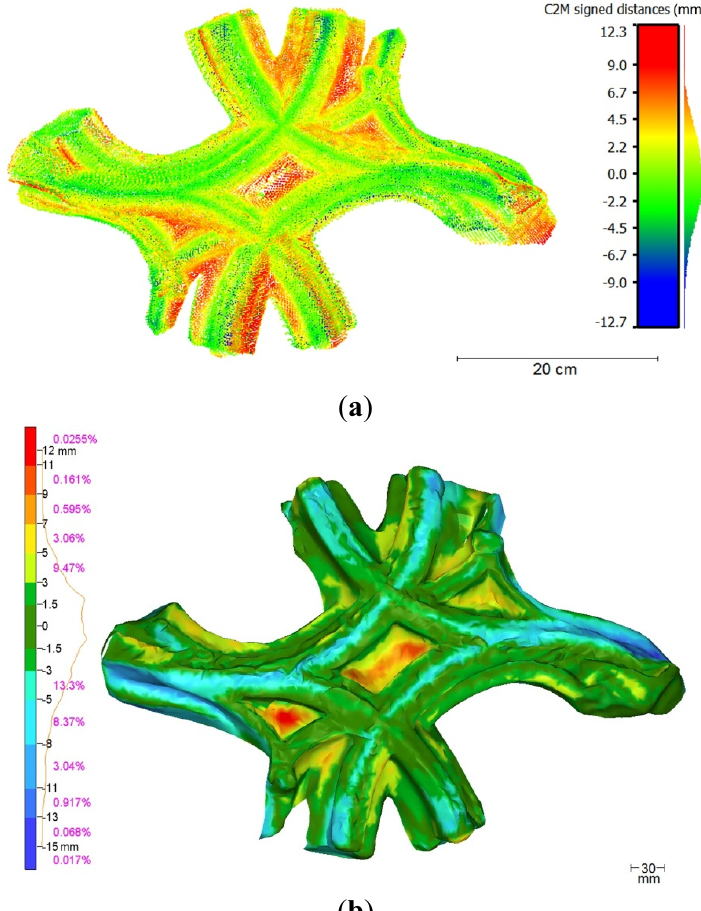
Figure 12. ( a ) Comparison between Kinect-based point cloud and reference mesh; and ( b ) comparison between mesh created from Kinect point cloud and reference